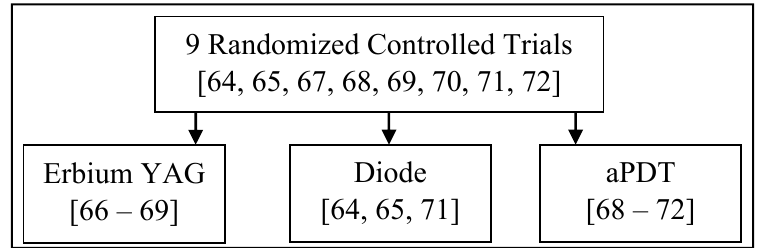
Figure 3. Comparison assessment of the studies according to wavelength.